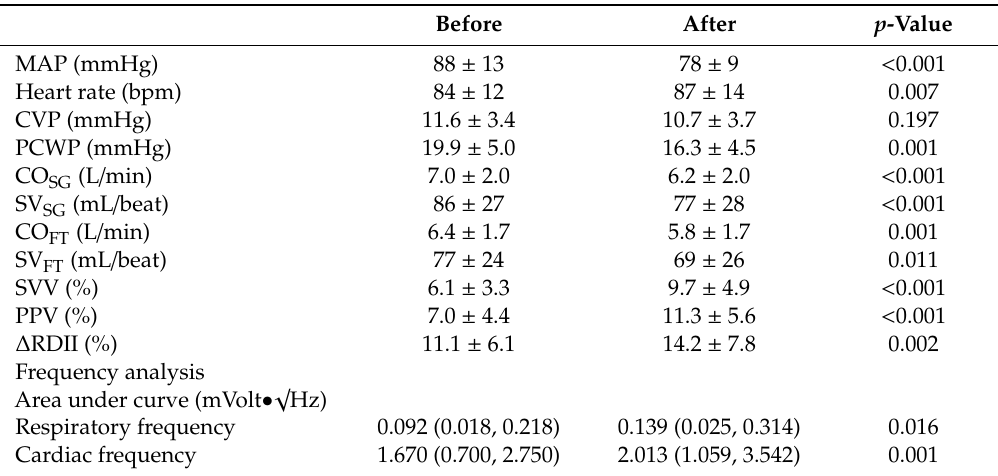
Table 2. Comparison of ∆ RDII and other variables during IVC clamping ( n = 34).